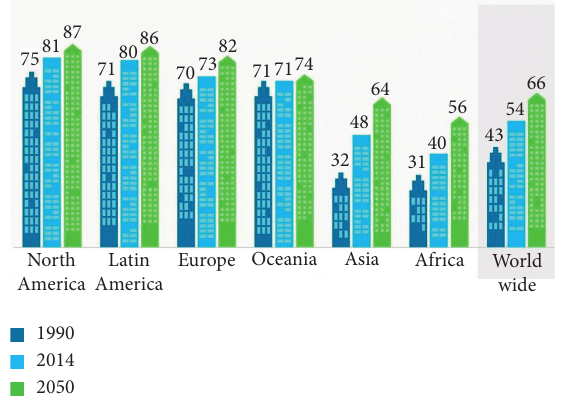
Figure 4: Increase in population in cities.